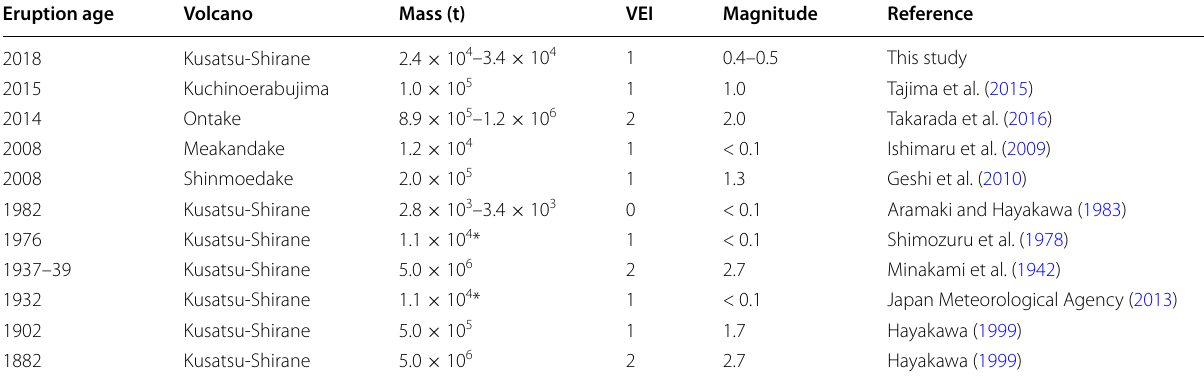
VEIs and magnitudes obtained using the total mass are also shown *Converted volume described in reference to mass using a tephra density of 700 kg/m 3